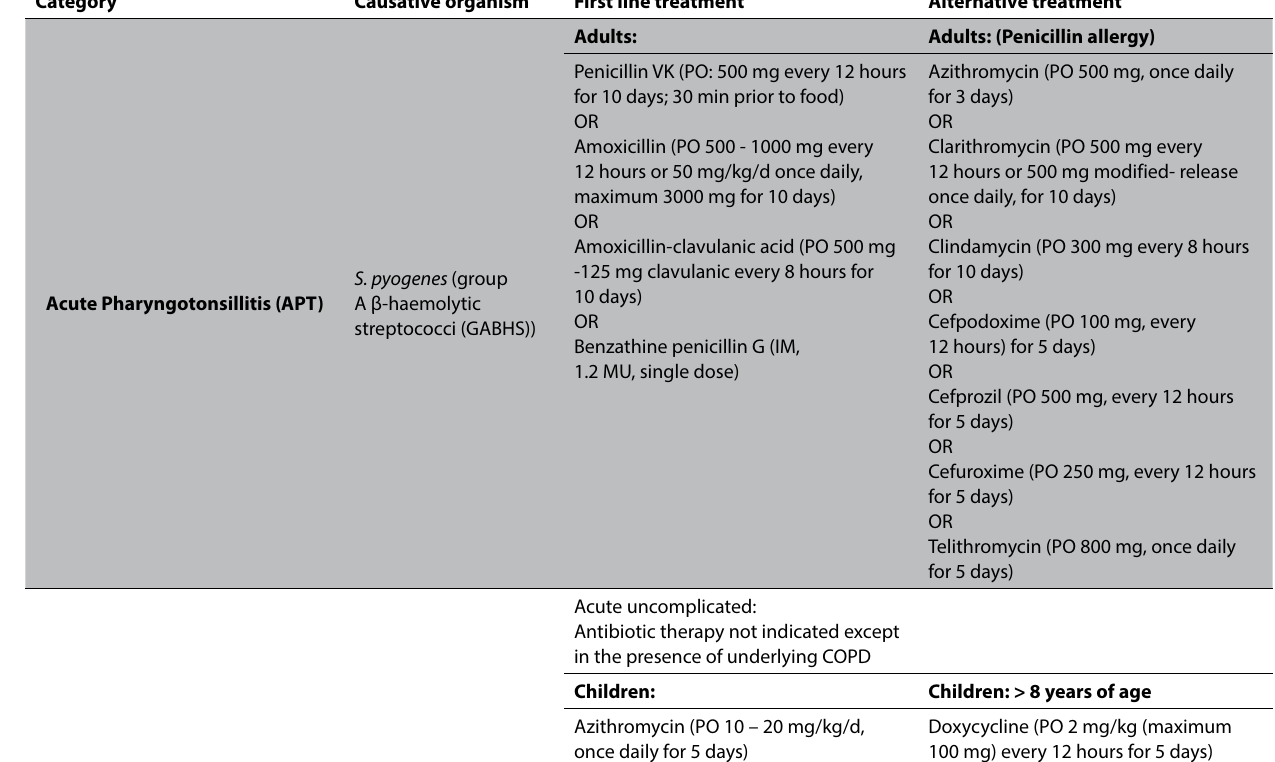
Table I. Main antibiotic treatment options for Upper and Lower Respiratory Tract Infections of bacterial origin (CONT.). 1,2-8,10,12-19,21,23,25-27